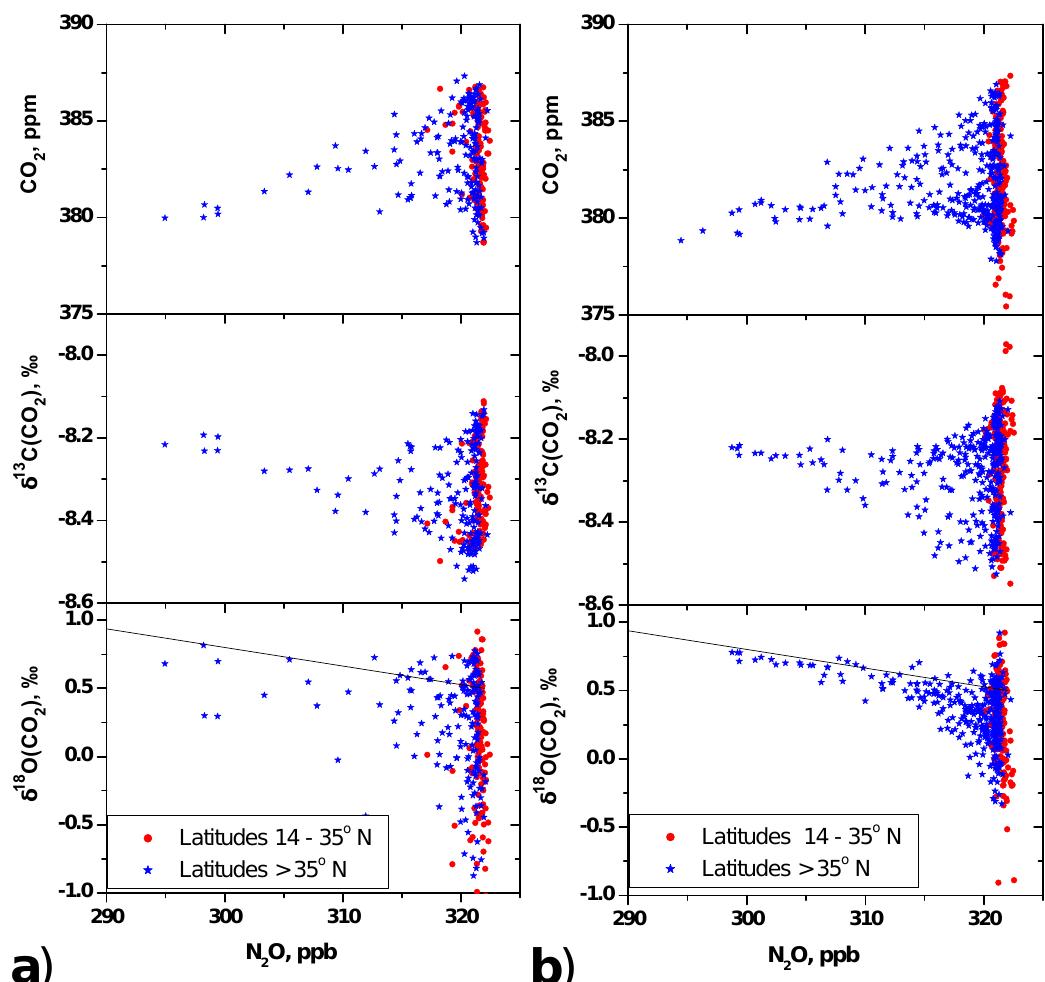
Fig. 7. The UT/LMS mixing trends for CARIBIC-1 (a) and CARIBIC-2 (b) . For CARIBIC-2 the trends are visible both in CO 2 , δ 13 C(CO 2 ) and in δ 18 O(CO 2 ) . The CARIBIC-1 δ 18 O(CO 2 ) data are qualitative only. UT/LMS mixing trends form triangle-shaped areas; this mixing affects latitudes above 35 ◦ N only. The trend line for δ 18 O(CO 2 ) is evaluated based on the data for stratospheric CO 2 , see